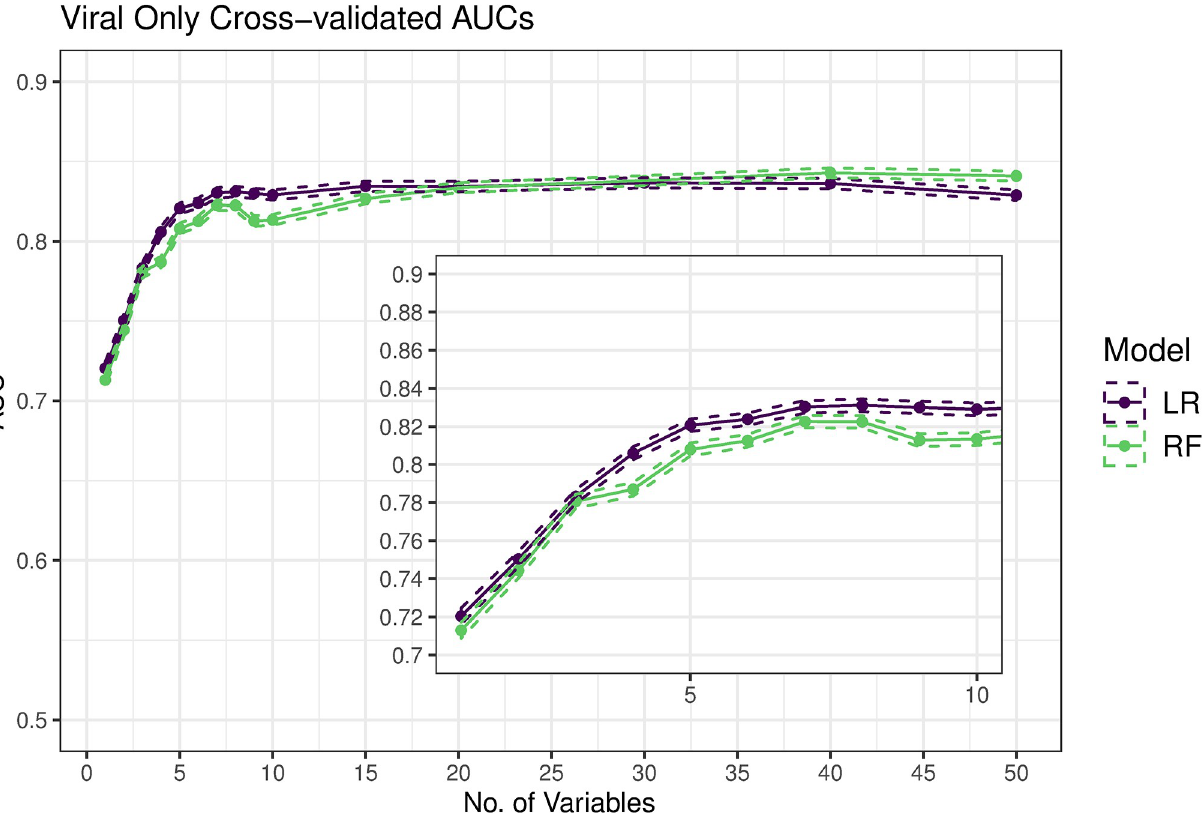
Fig 1. Average AUC and 95% CIs from cross-validation (100 iterations) for both a logistic regression (LR) and random forest (RF) as the number of variables in the model increases and inset shows zoomed in graphs of 1 through 10 variables.